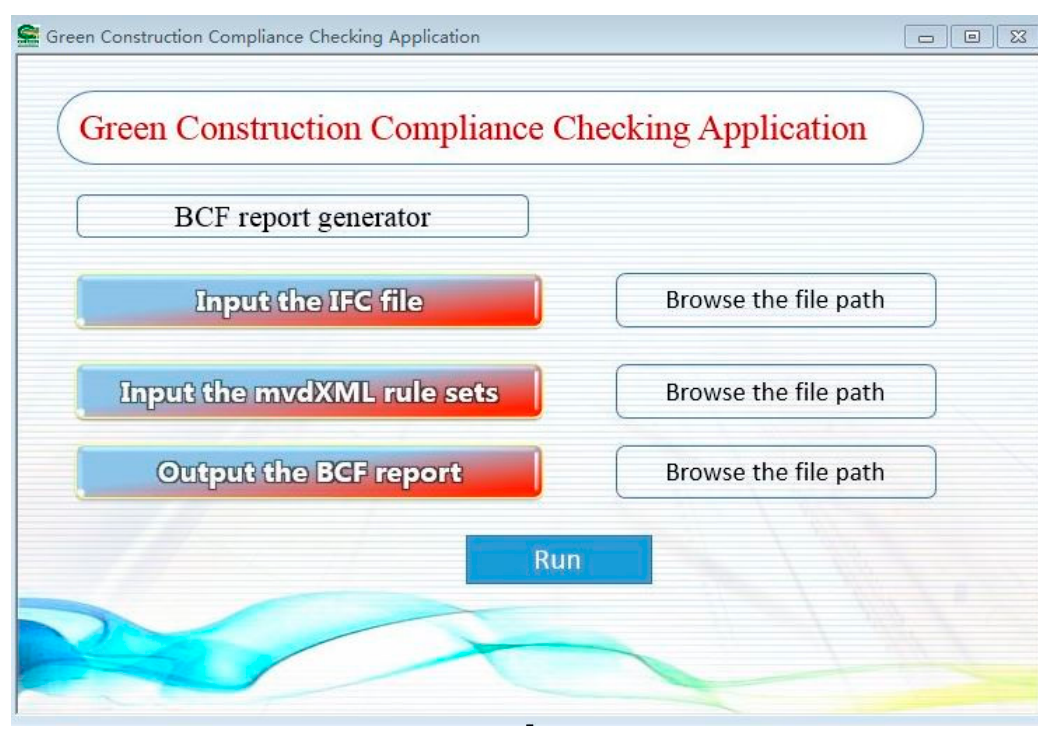
Figure 10. BCF report generator.